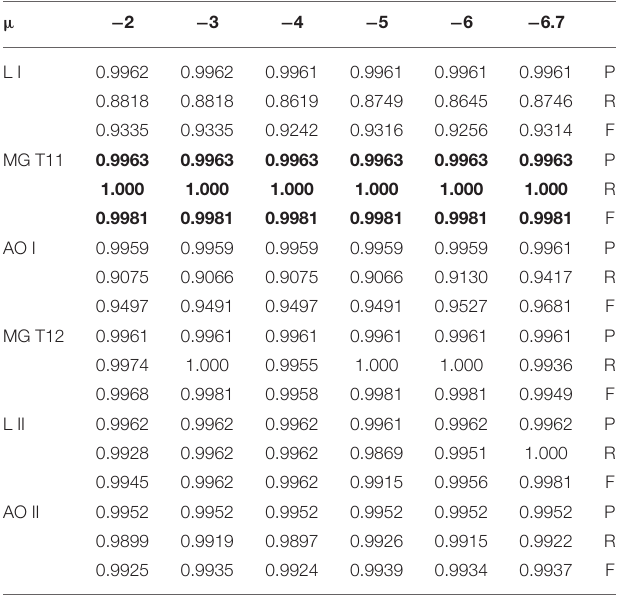
TABLE 3 | Image of group 2 of the range of µ was from − 2 to − 6.7.